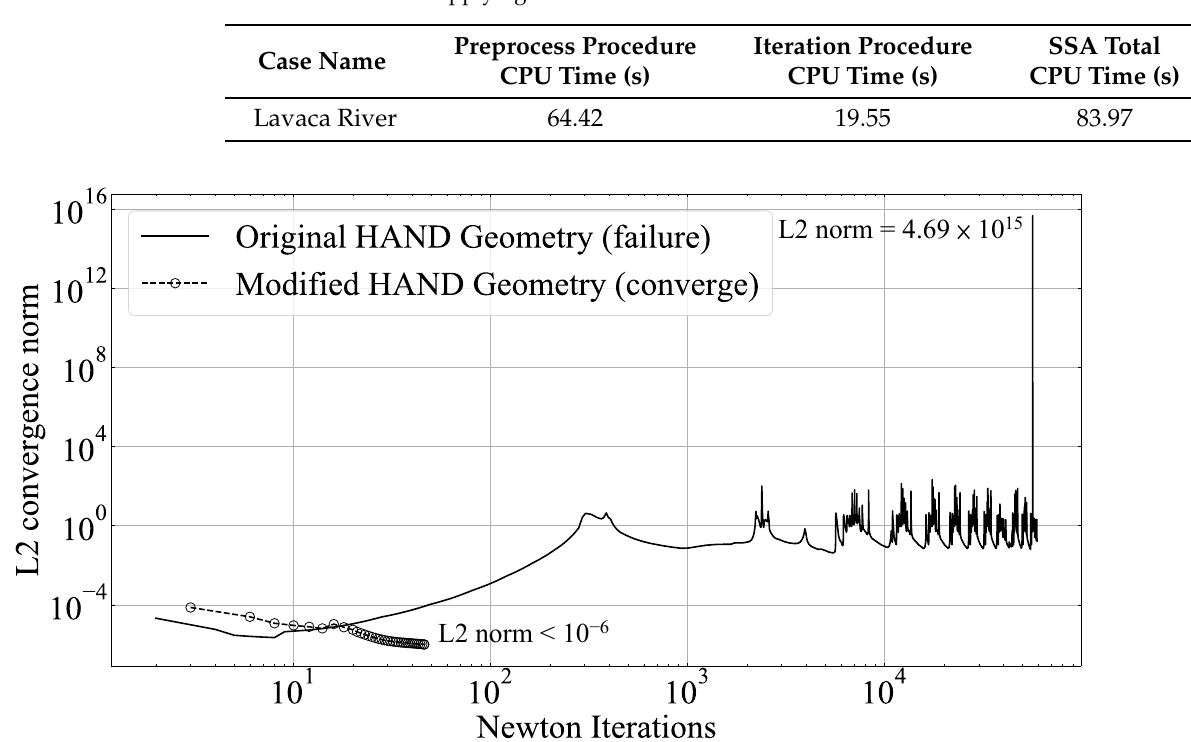
Table 2. CPU time of applying SSA method on Lavaca River network.